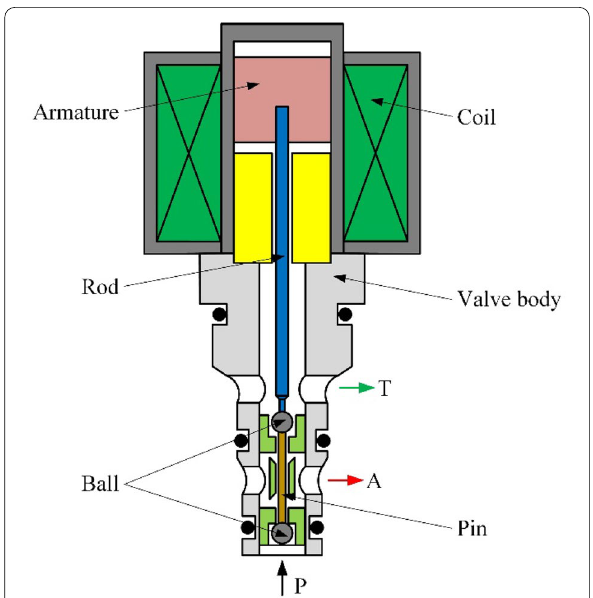
Figure 1 Ball valve with a threaded cartridge structure developed by Honglin Machinery